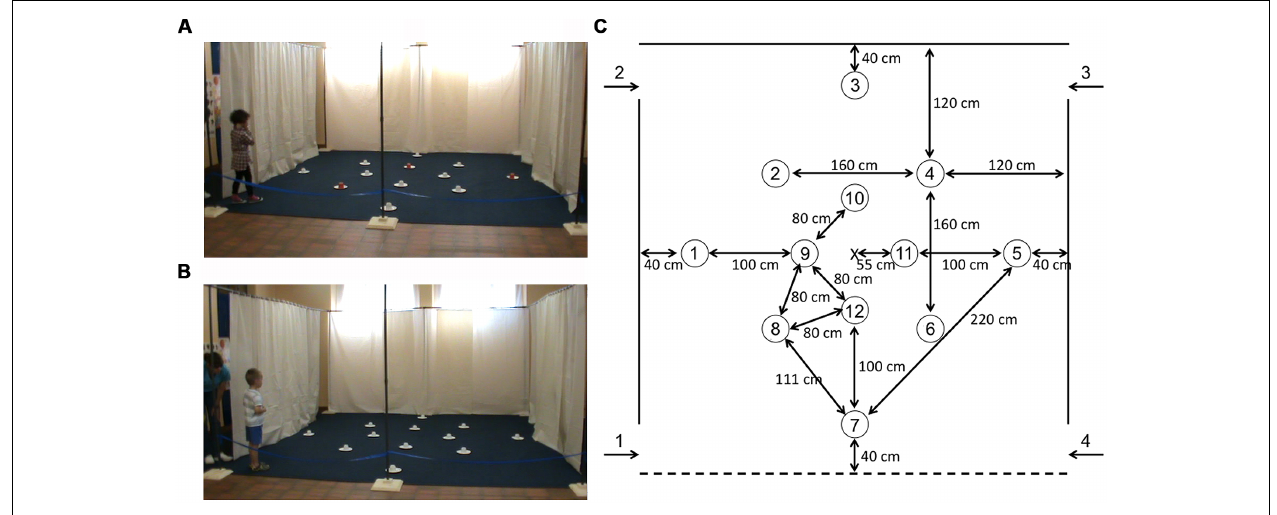
FIGURE 1 | Experimental setup. (A) Picture of a TD participant in the arena in the local cue (LC) condition (note the three red cups at positions 5, 8, and 10). (B) Picture of a TD participant in the arena in the allocentric spatial (AS) condition (all cups are white). (C) Schematic representation of